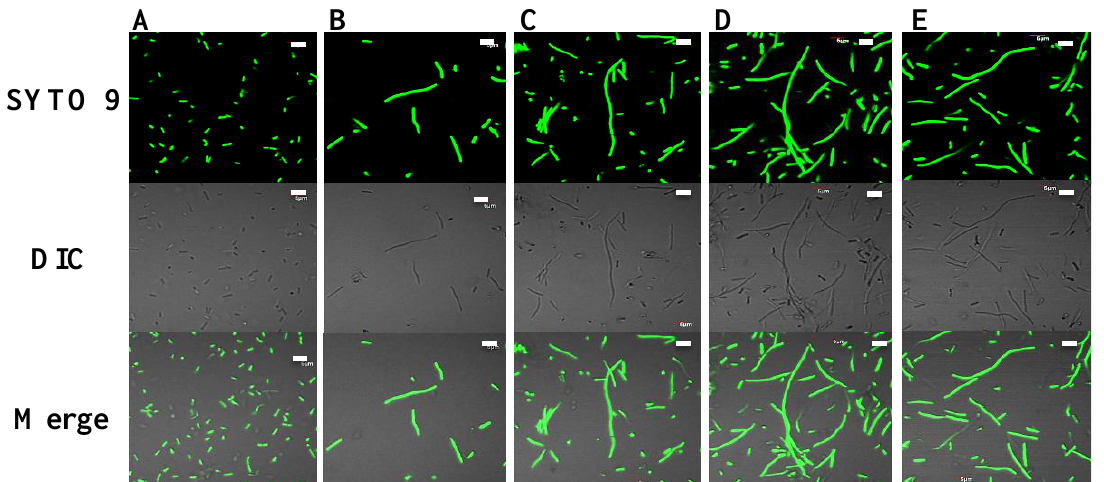
Figure 4. Filamentation in E. coli cells induced by peptides. Cells were observed using confocal microscopy at × 1000 magnification under oil immersion, after incubation with peptides for 3 h at 37 °C. ( A ): no-peptide control; ( B – E ): cells treated with varying final concentrations of peptides as per their 1 × MIC; ( B ): PuroA (16 µg/mL); ( C ): W7 (4 µg/mL); ( D ): P1 (16 µg/mL); ( E ): WW (8 µg/mL). Scale bar 5